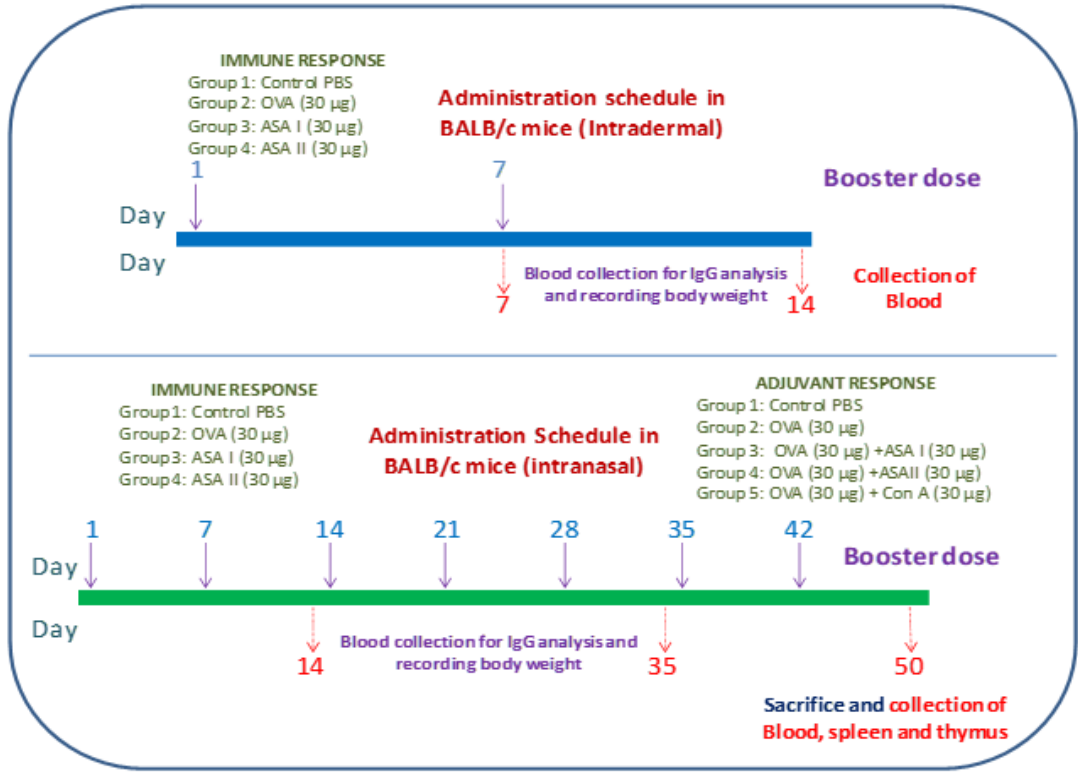
Figure 2. Systemic and mucosal administration schedule of garlic lectins in BALB/c mice model; Intradermal systemic immunization schedule. The animals were given the initial dose on day 1, and the subsequent booster dose was administered on day 7. Blood was drawn on days 7 and 14 for examining the immune response; Intranasal mucosal immunization schedule. The animals were given the initial dose on day 1, and the subsequent booster doses were administered on 7th, 14th, 21st, 28th, 35th, and 42nd days. Blood was drawn on days 7, 35, and 50 for measuring the immune